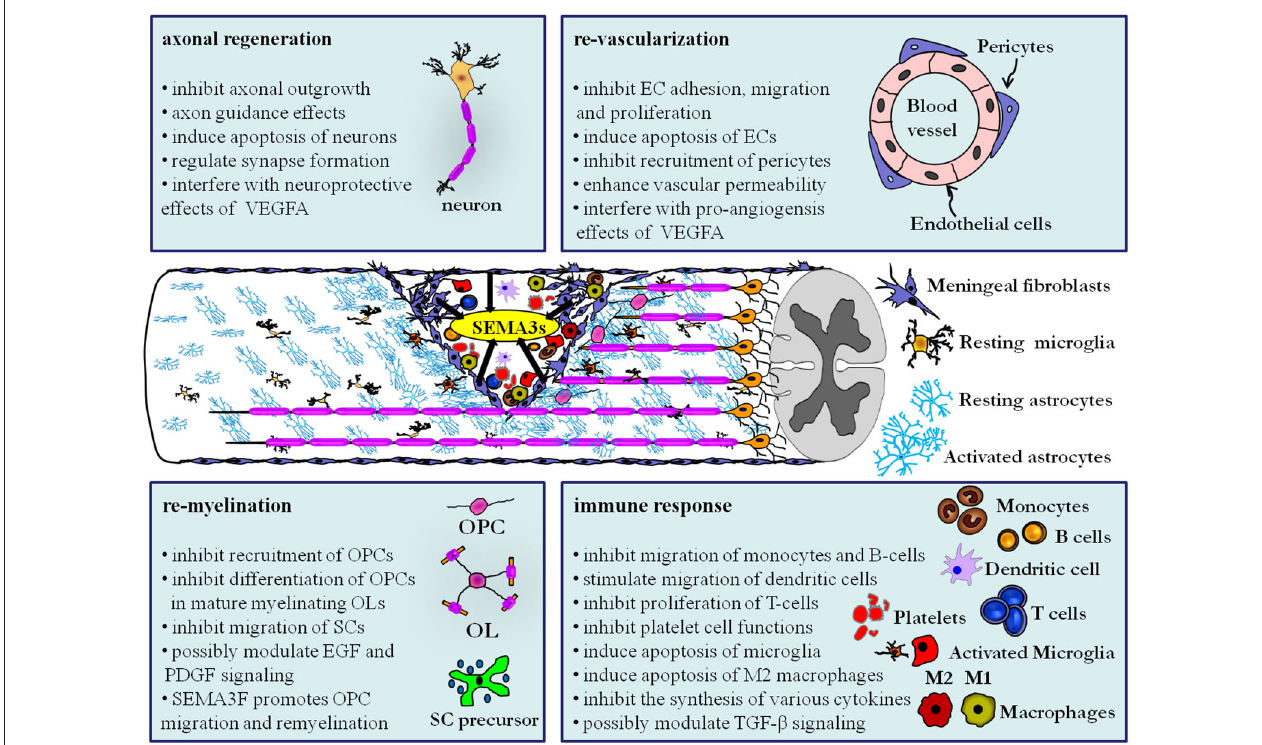
core as a result of blood vessel rupture. As discussed in this review, the role of SEMA3s goes beyond inhibiting axonal regeneration and could be a significant target for future studies to stimulate repair following CNS trauma. Abbreviations: B-cell, B-lymphocyte; EC, endothelial cell; EGF, epidermal growth factor; OL, Oligodendrocytes; OPC, oligodendrocyte precursor cells; PDGF, platelet-derived growth factor; SC, Schwann cells; T-cell, T-lymphocyte; TGF- β , transforming growth